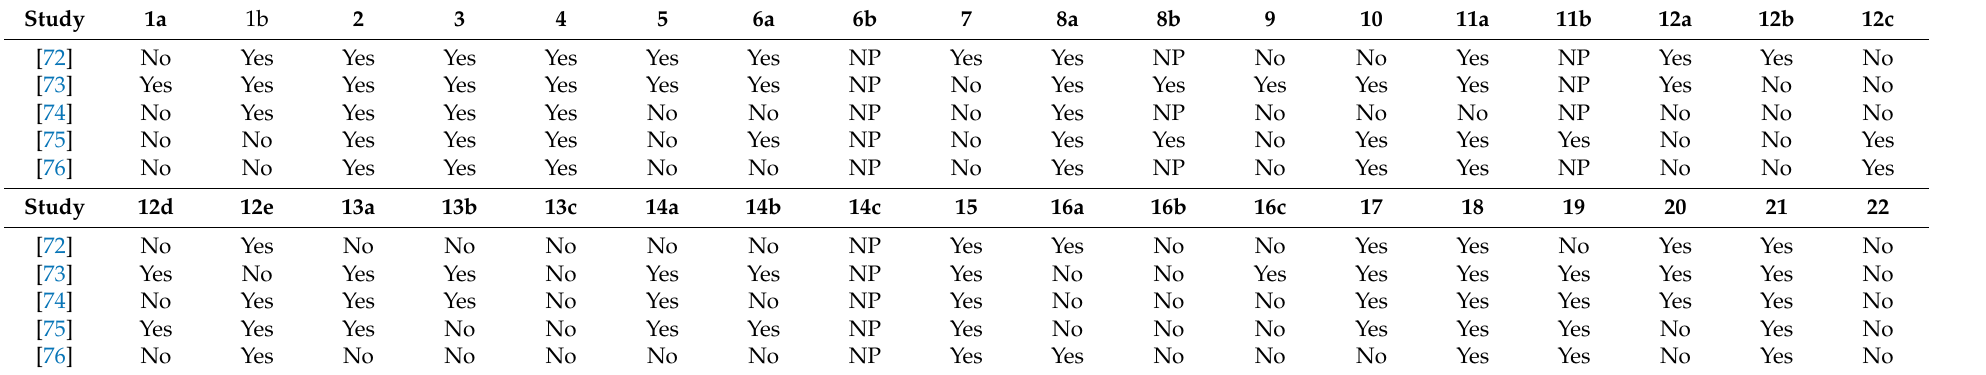
Table A2. STROBE Checklist of the top five observational studies per